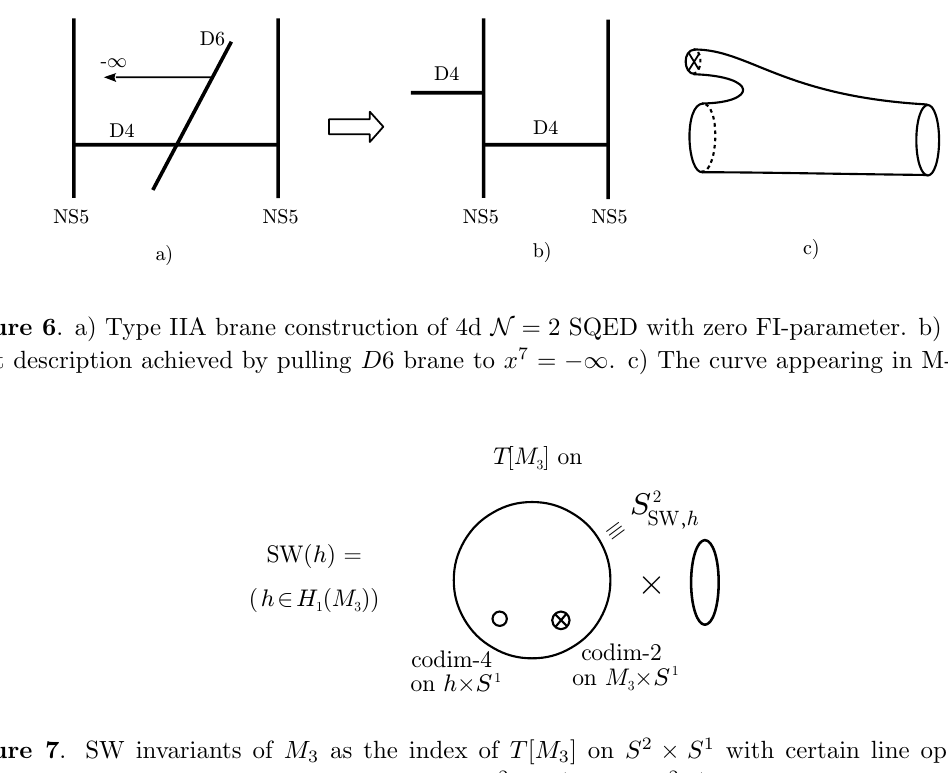
(or just S 2 ) to denote sphere with such SW SW ;h